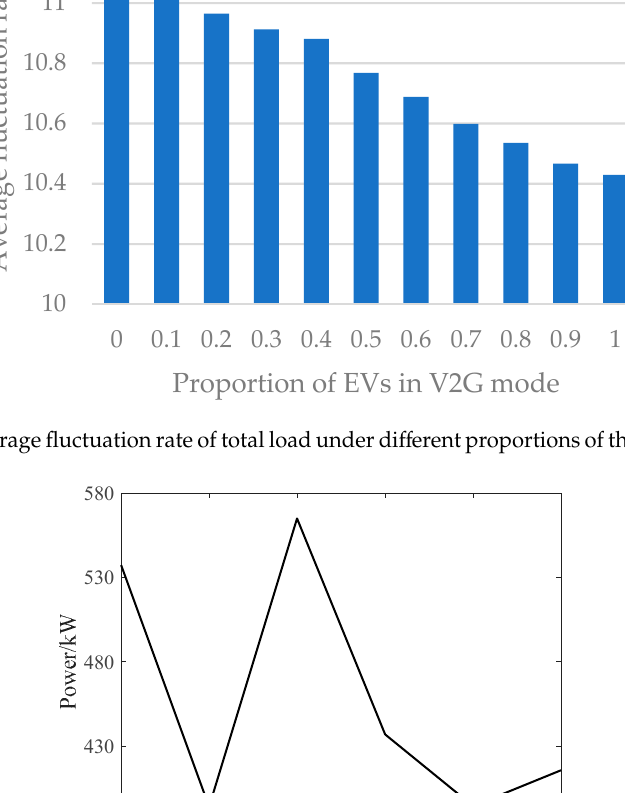
Figure 15. Sudden drop in wind energy output.